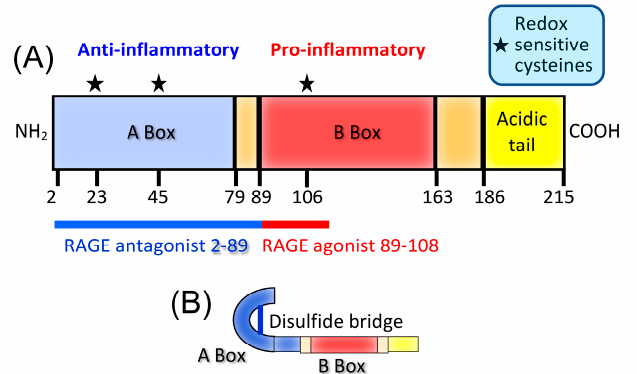
Figure 4. The alarmin HMGB1 contains both pro- and anti-inflammatory domains, and its action is governed by its oxidative state. ( A ) HMGB1 consists of the anti-inflammatory A box, which is a RAGE antagonist; a pro-inflammatory B box, which is a RAGE agonist; and an acidic tail. ( B ) For HMGB1 to have pro-inflammatory activity, the cysteines at positions 23 and 45 in the A box must form a disulfide bridge and the cysteine at position 106 of the B box must be fully reduced and contain a thiol side chain. In the oxidizing extracellular environment, the B box is a pro-inflammatory mediator.